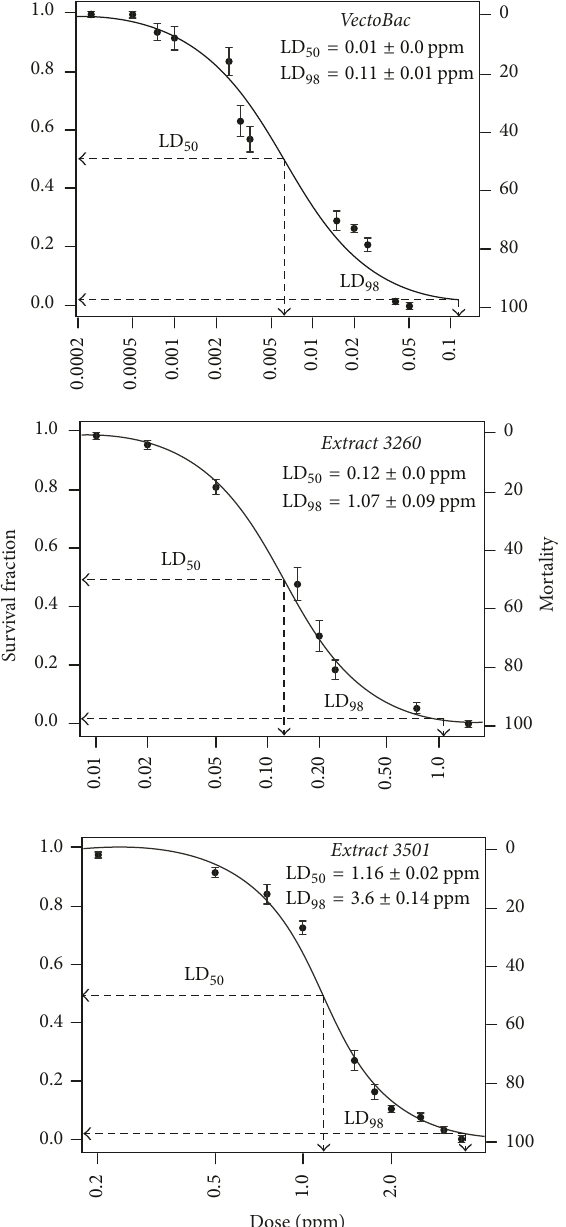
Figure 3: LD 50 and LD 98 of fermentation extracts 3501 and 3260 from Bacillus thuringiensis var. israelensis